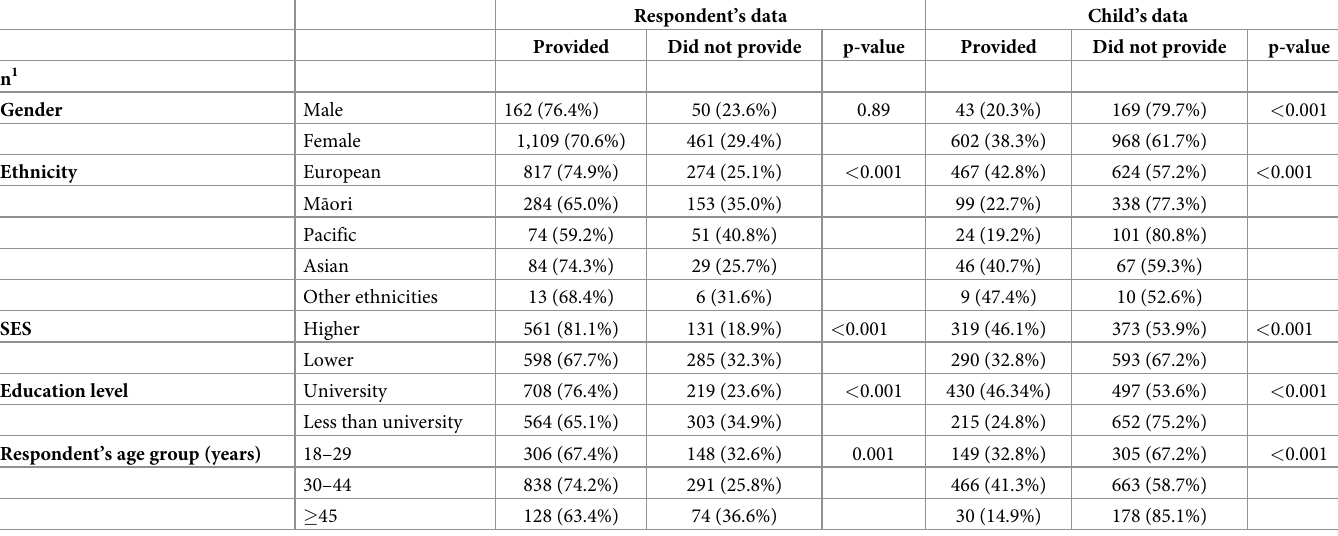
Table 4. Sociodemographic characteristics of those who did or did not provide their own and/or their child’s anthropometric